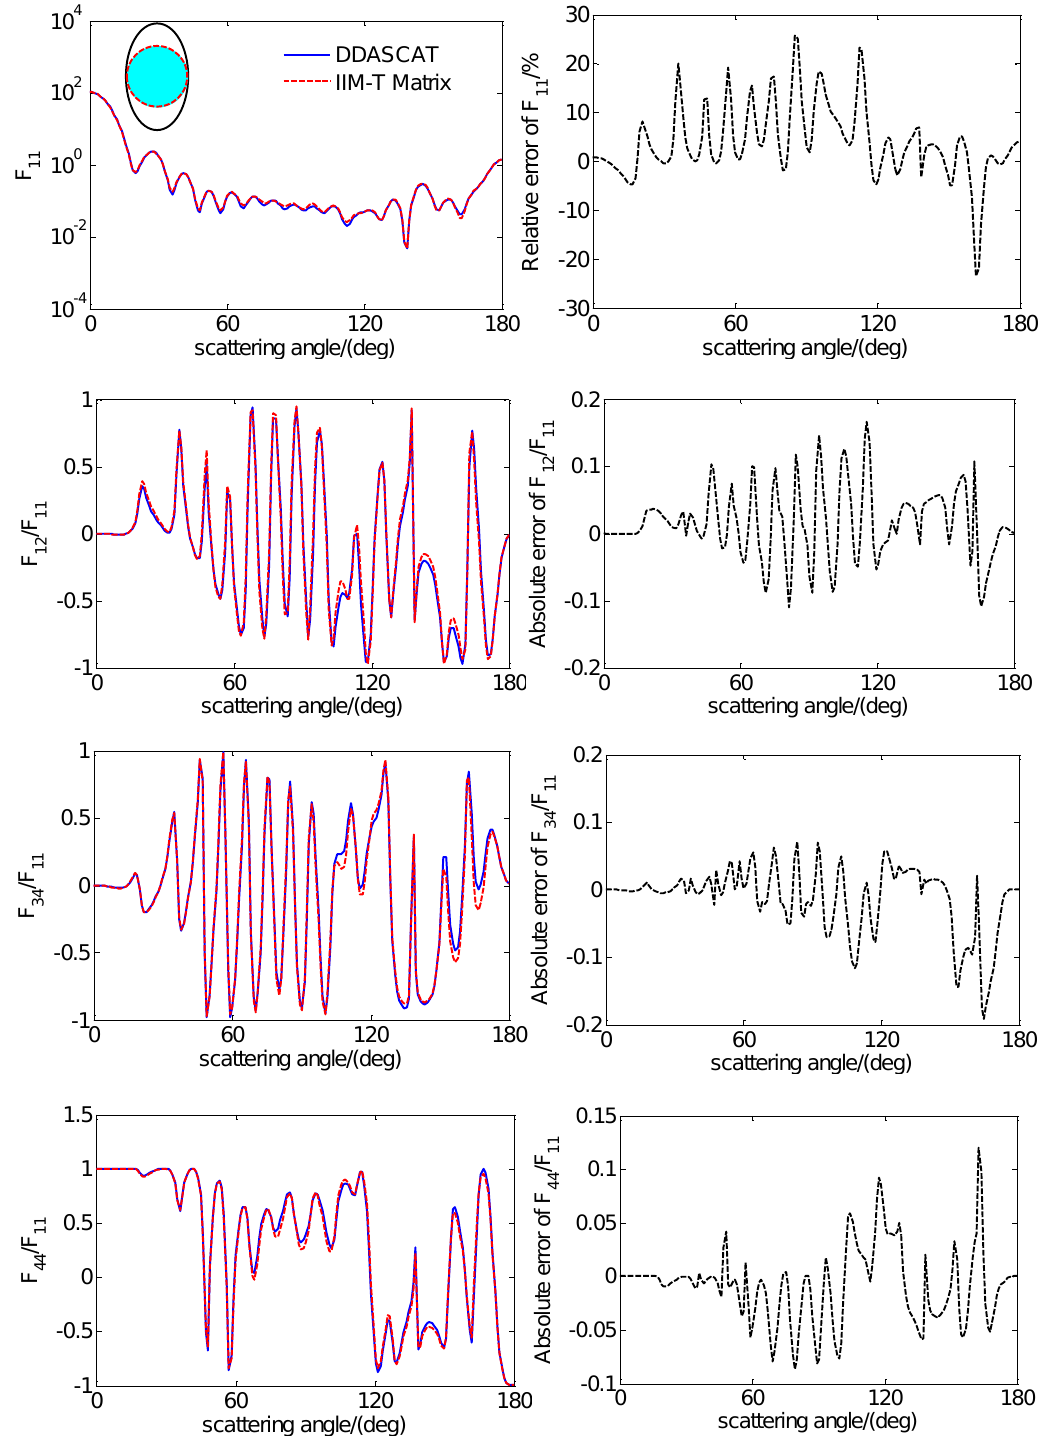
Figure 7. The scattering phase matrix obtained by the IIM T-Matrix method and DDASCAT for the spheroidal particle with a spherical core. The simulation errors of F 11 are denoted by relative errors. For F 12 , F 34 , and F 44 , they are firstly normalized by F 11 , and their simulation errors are evaluated by the absolute errors.